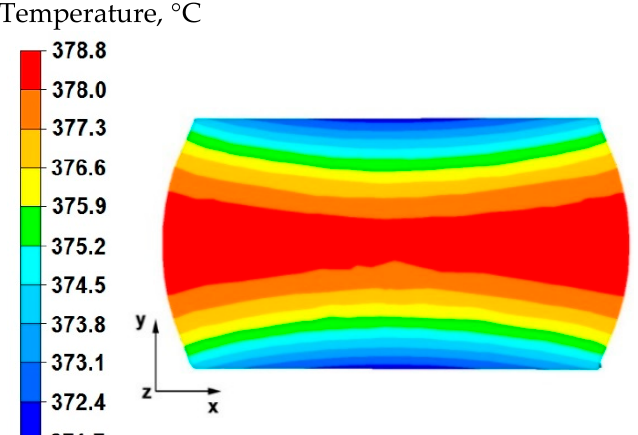
Figure 12. Distribution of temperature values on the surface of the cross-section of the sample with modeled discontinuity after deformation with 35% reduction.